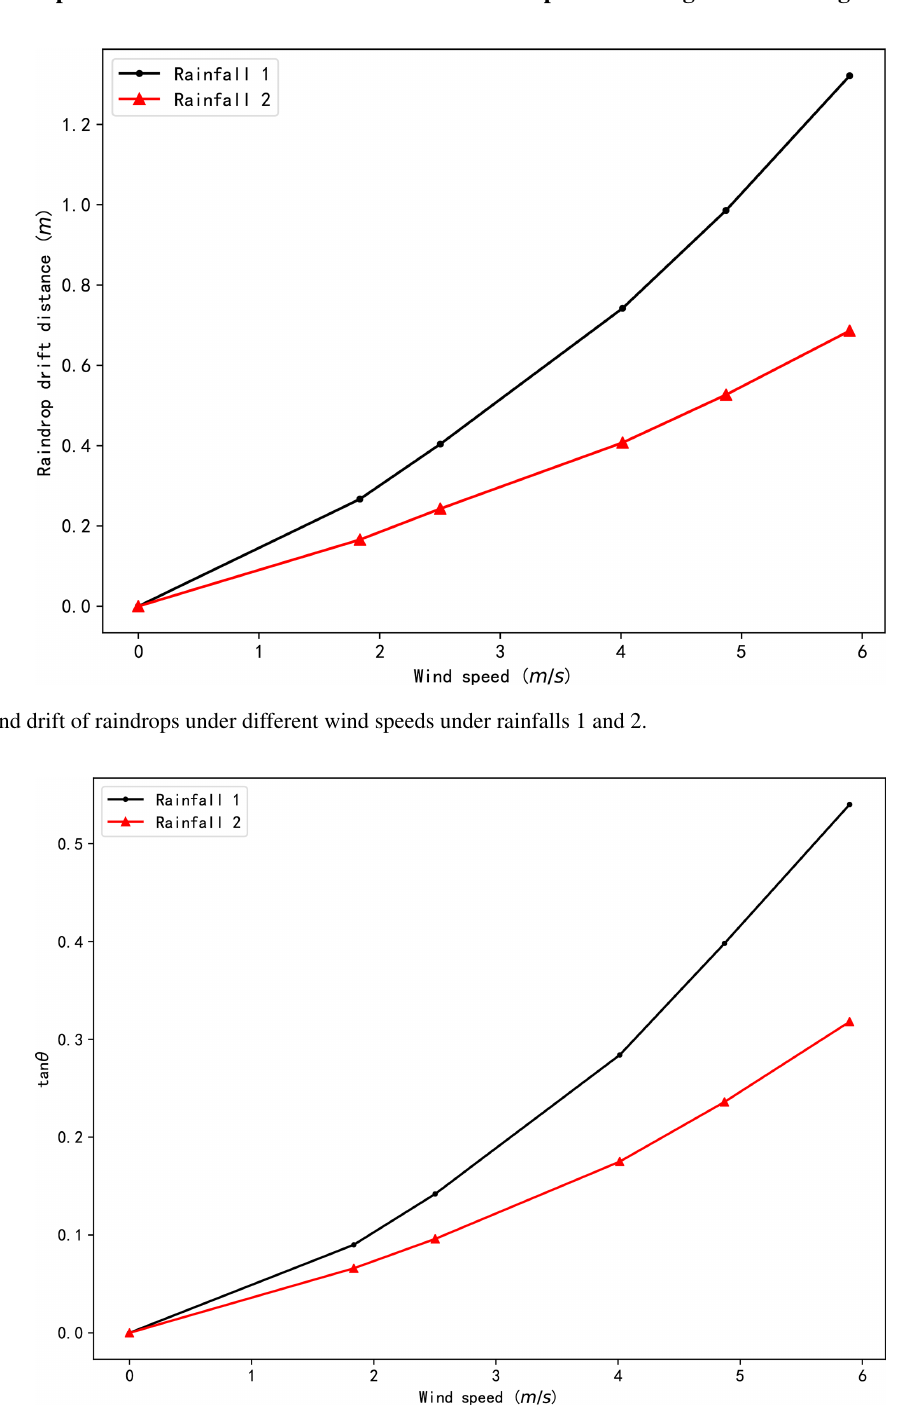
Figure 11. The tangent of the raindrop trajectory inclination angle for different wind speeds under rainfalls 1 and